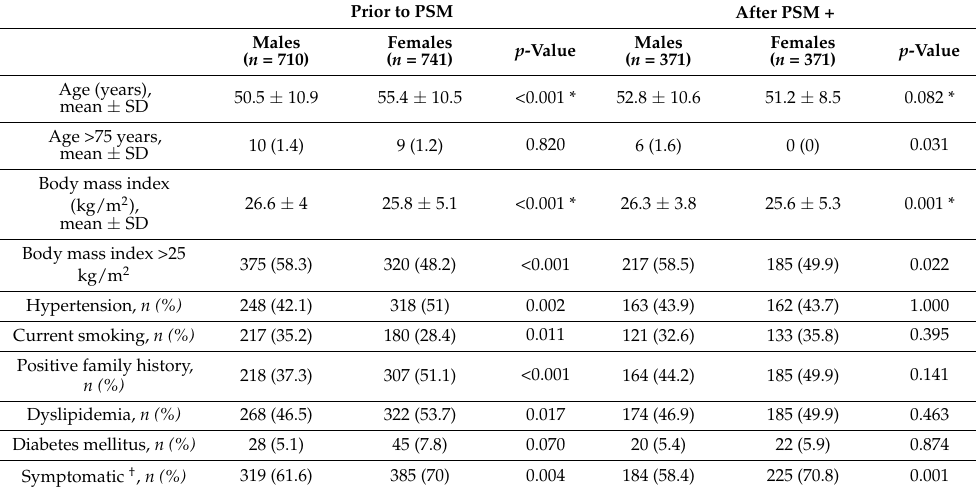
Table 1. Baseline characteristics of the study population before ( n = 1451) and after propensity score matching (PSM) ( n = 742).